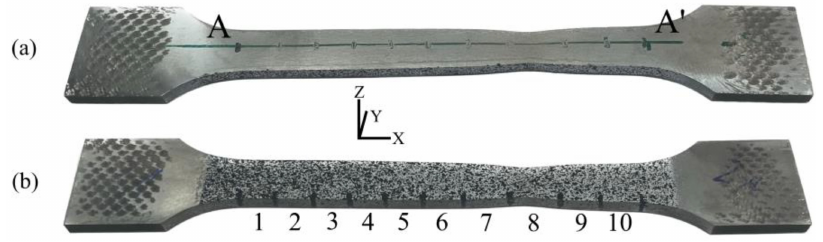
Figure 1. Specimen surfaces prepared for investigating with contact profilometry ( a ) and digital image correlation ( b